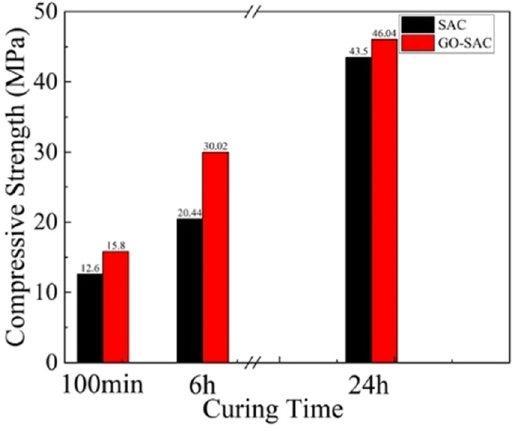
Figure 1: Compressive strength of GO - SAC and SAC at increasing curing times [ 15 ] .